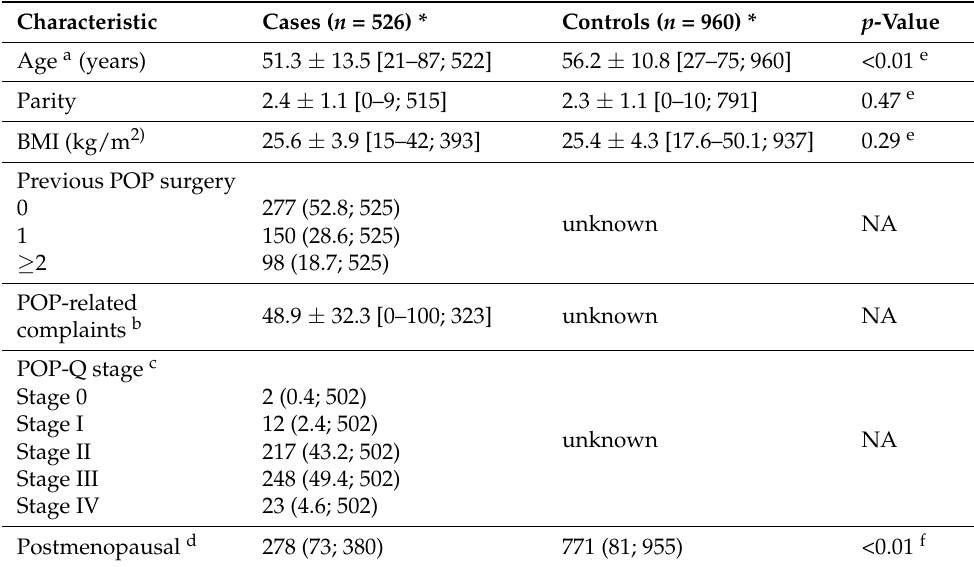
Table 1. Characteristics of POP cases and controls that were analyzed in the exome chip